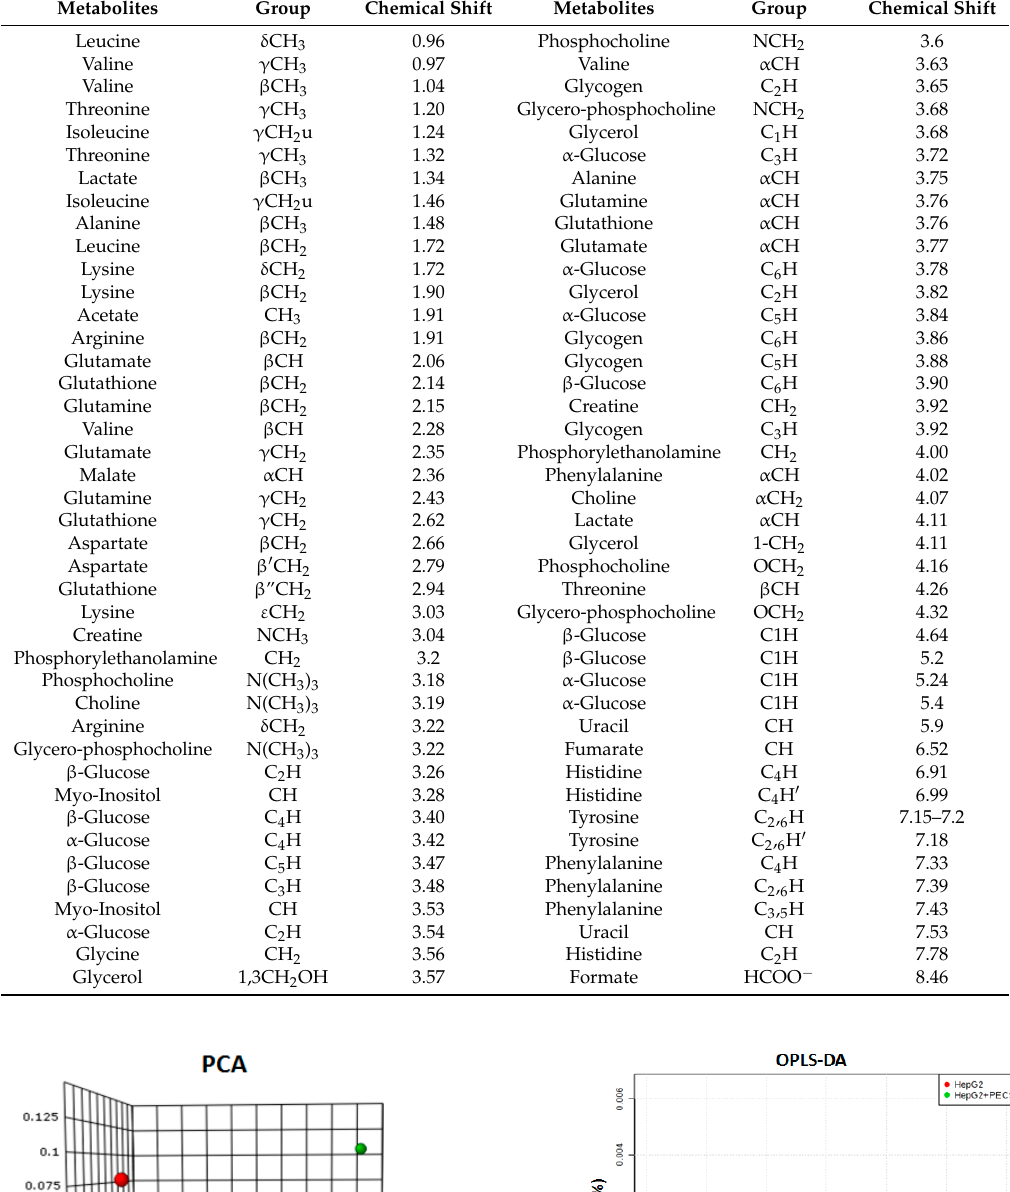
Table 5. List of 1 H chemical shift (ppm) of metabolites found in HepG2 cells. Metabolites Group